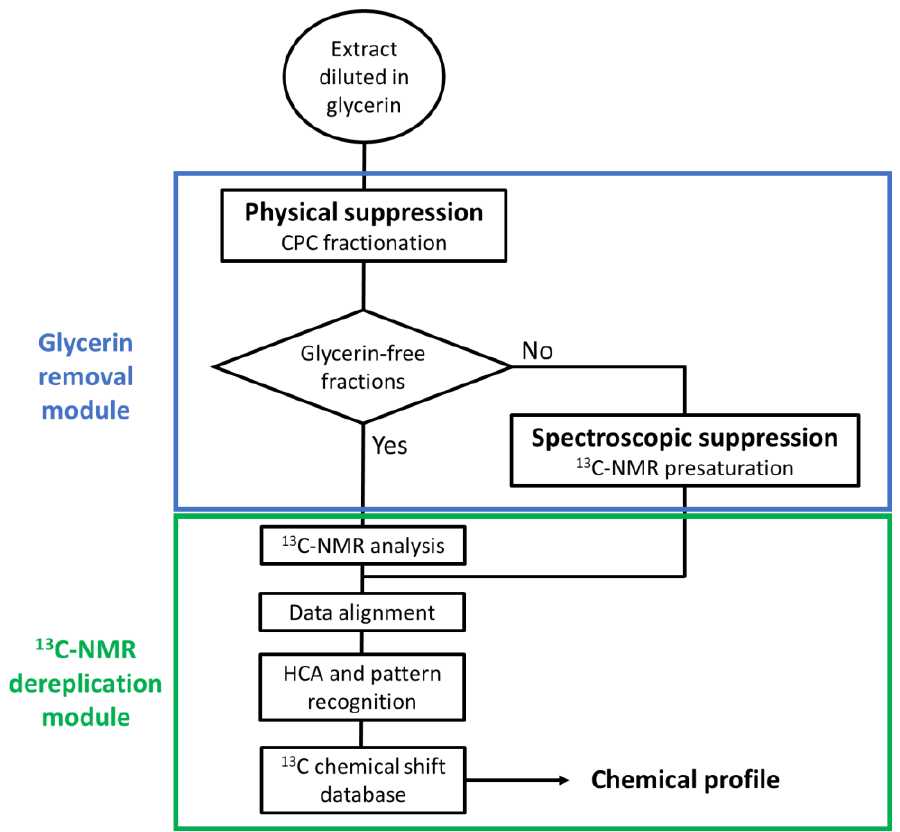
Figure 1. Global workflow for the dereplication of natural extracts diluted in glycerin. CPC: Centrifugal partition chromatography; HCA: Hierarchical clustering analysis.